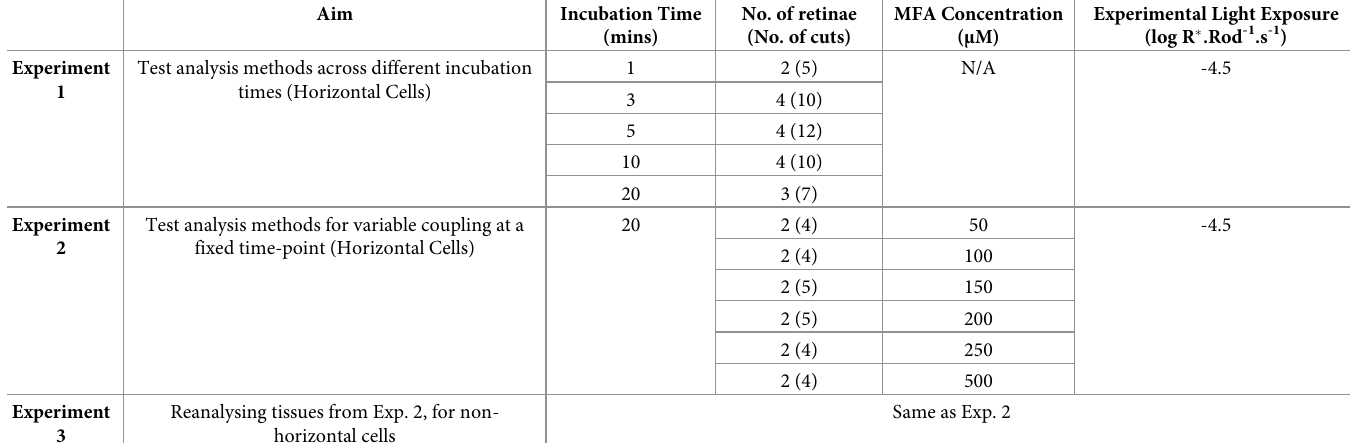
Table 1. Experimental design showing the primary variables manipulated. The Experimental Light Exposure refers to the light level during cut-loading at a wavelength of 850nm and was approximately equivalent to total